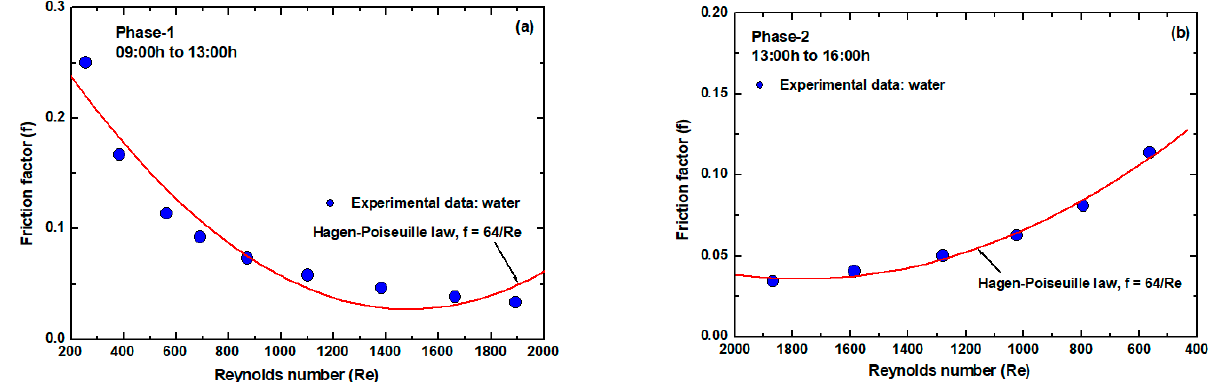
Figure 14. Experimental friction factor validation with literature values; Phase-1 ( a ), and Phase-2 ( b ).